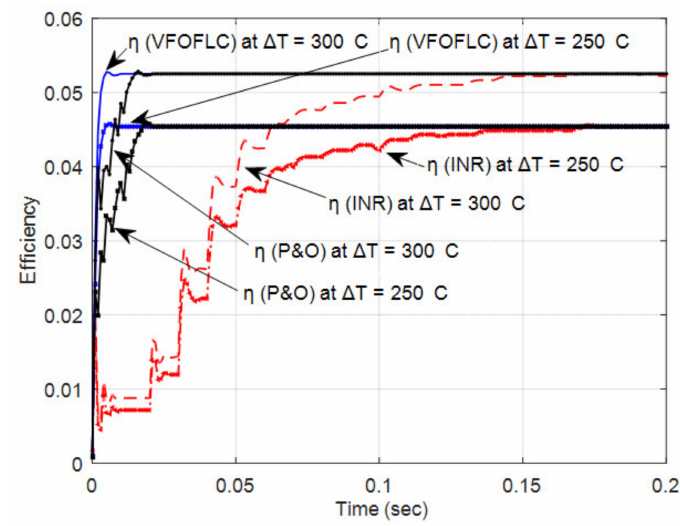
Figure 17. The conversion e ffi ciency of the